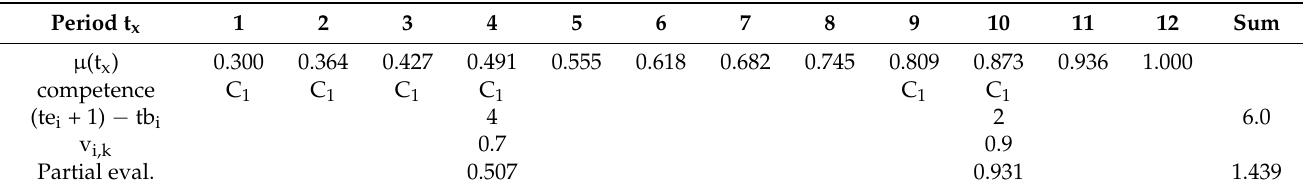
Table 1. An example of calculating the value of a single competency of an employee using Equation